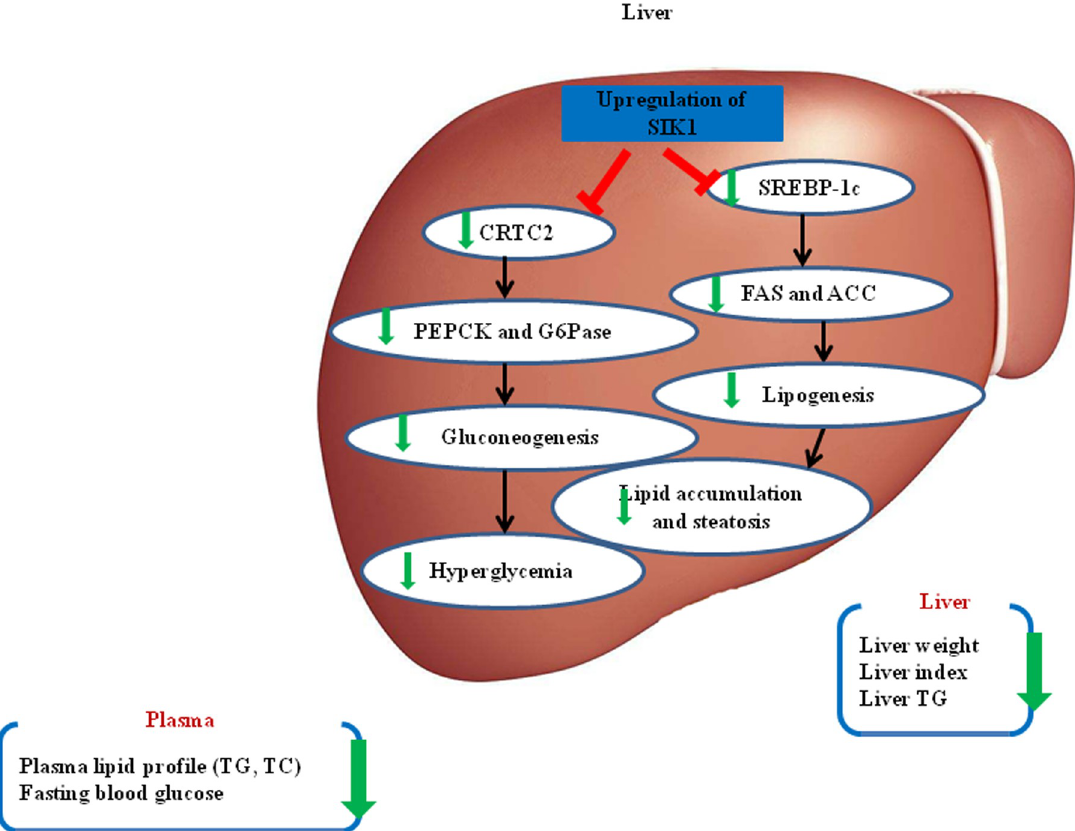
Fig 6. Proposed mechanisms of the hypoglycemic and hypolipidemic effect of SIK1. Schematic representation of the role of SIK1 in amelioration of T2DM with NAFLD. Overexpression of SIK1 can contribute to preventing hyperglycemia and hepatic lipid accumulation through suppressing gluconeogenesis and lipogenesis with a decrease in the expressions of CRTC2, PEPCK, G6Pase, SREBP-1c, FAS and ACC in liver, thus reducing fasting blood glucose, serum TC, serum TG, hepatic TG and liver weight. SIK1, salt- induced kinase 1; CRTC2, CREB-regulated transcription co-activator 2; PEPCK, phosphoenolpyruvate carboxykinase; G6Pase, glucose- 6-phosphatase; SREBP-1c, sterol regulatory element binding-protein-1c; ACC, acetyl-CoA carboxylase; FAS, fatty acid synthase; TC, total cholesterol; TG